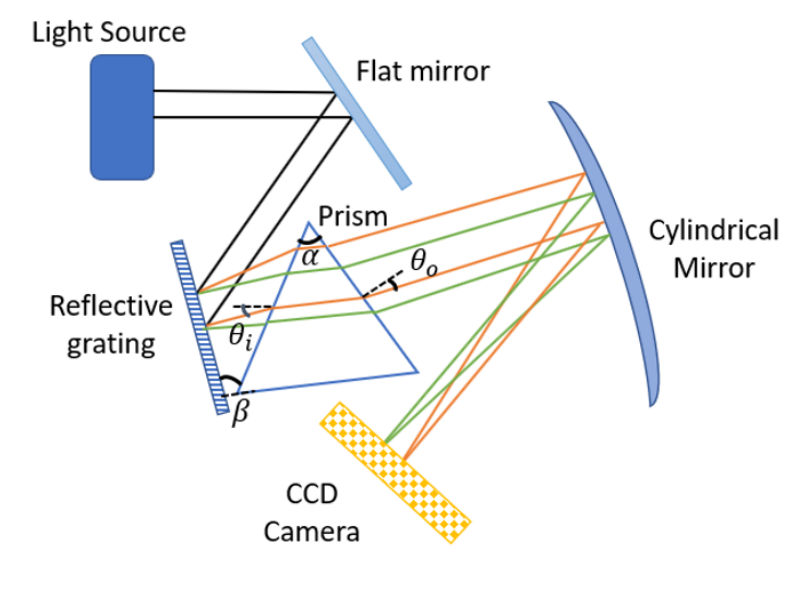
Figure 2. Schematic of the spectrometer using reflective grating and prism (two wavelengths, orange shorter and green